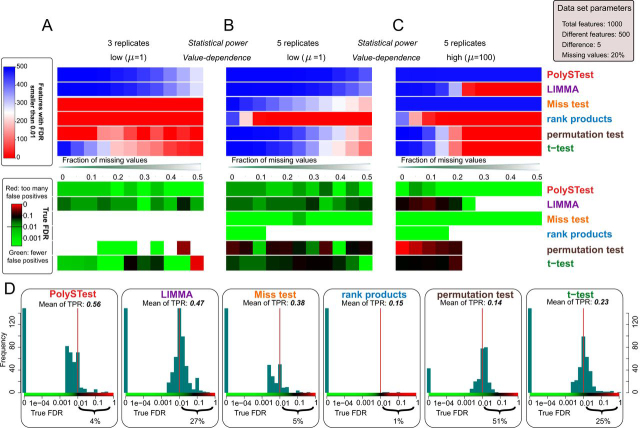
Complementarity of the different statistical tests improves DRF detection.A–C, Number of DRFs with given FDR smaller than 0.01 and calculated true FDR (from ground truth) for three representative artificial data sets. The results were assessed for different amounts of missing values and show that Miss test complements and therefore improves both DRF detection and confidence for sufficiently high replicate numbers and abundance-dependence of missing values. D, Distribution of true FDRs at a given FDR of 0.01 for 1584 artificial data sets spanning 3–10 replicates, 2–100 truly regulated proteins shifted by 1, 1.5, 2 and 5 from their original random value, and 0–100 abundance-dependence μ and missing values of 0–50%. This shows that combining the different statistical tests provide optimal numbers of true positives with high confidence (low percentage of too high true FDRs) over the range of tested data sets.